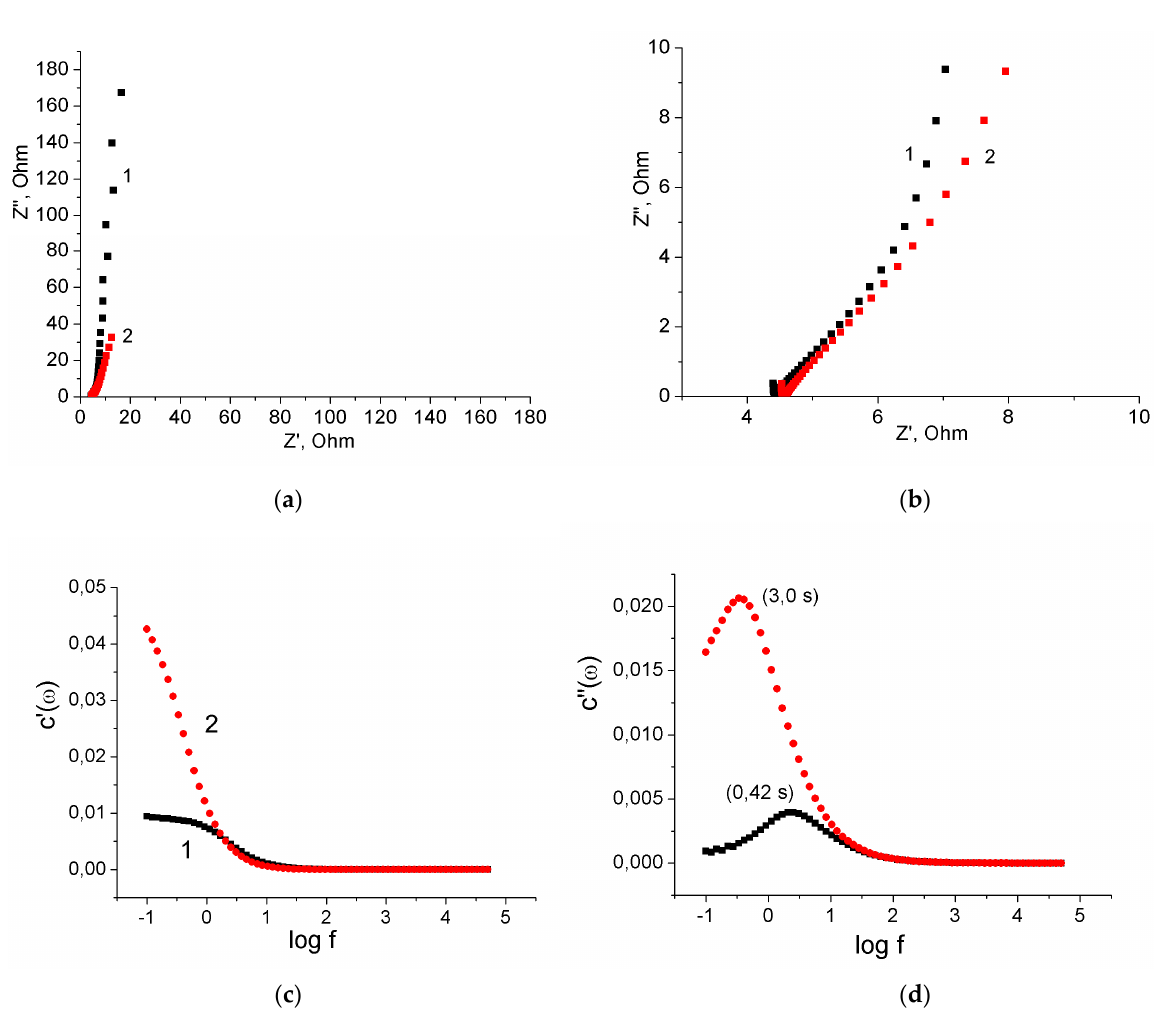
Figure 6. ( a ) The Nyquist plots of the three-electrode cell (full range); ( b ) The Nyquist plots of the three-electrode cell (middle range); ( c ) Frequency dependences of the real capacitances; ( d ) Frequency dependences of the imaginary capacitances. As-prepared MWCNT/Al sample 1, MnO 2 /MWCNT/Al sample 2.